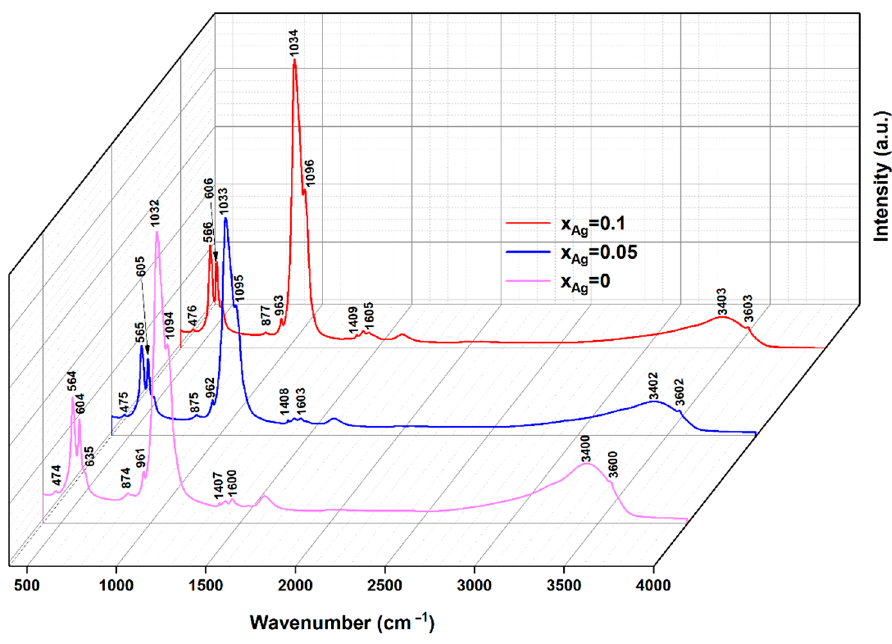
Figure 6. 3D representation of the FTIR spectra of silver doped hydroxyapatite thin films (x Ag = 0; 0.05 and 0.1).